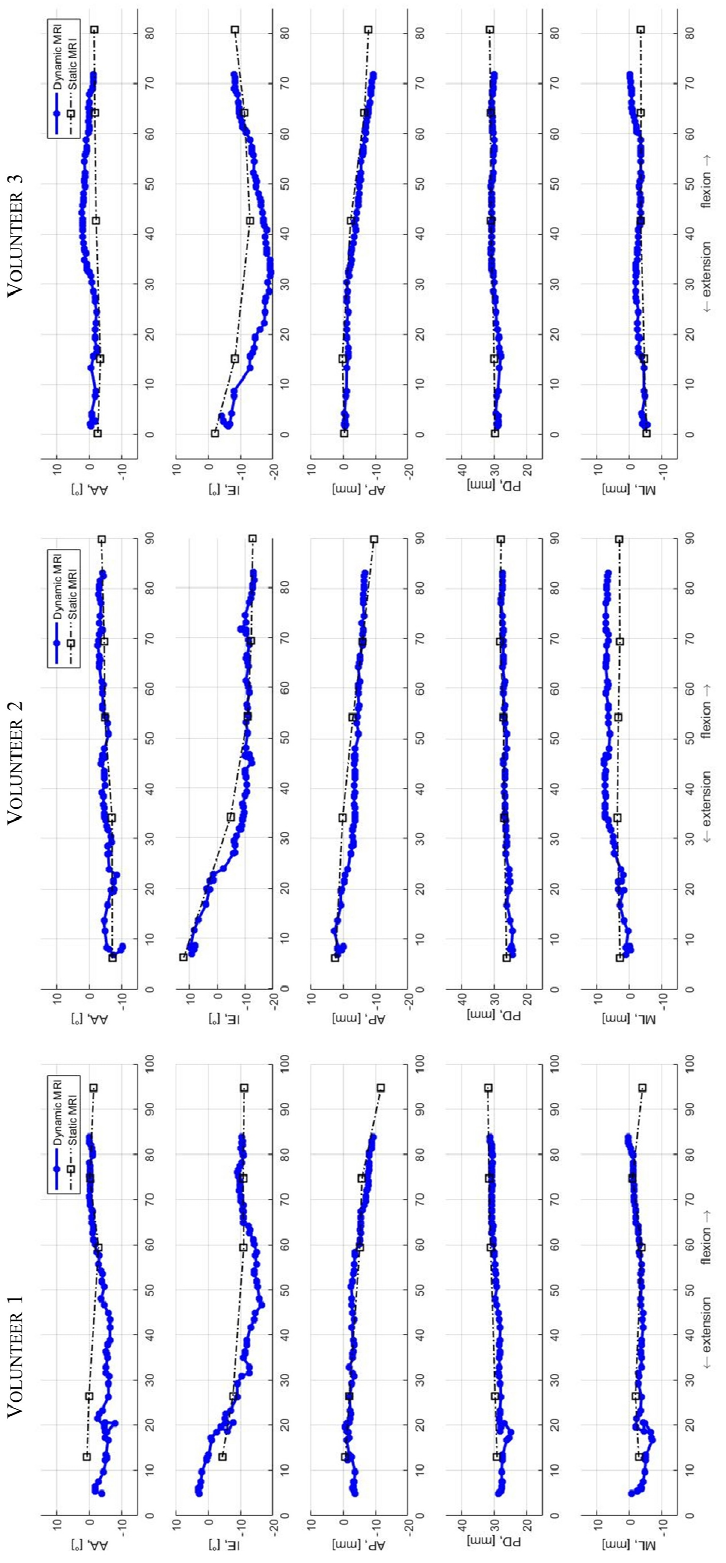
Figure 7. Comparison between knee kinematics reconstructed from dynamic (blue) and static (black) MRI. The Abduction/adduction (AA), internal/external rotation (IE), anterior/posterior (AP), proximal/distal (PD), and medial/lateral (ML) translations are plotted vs. the knee flexion angle.